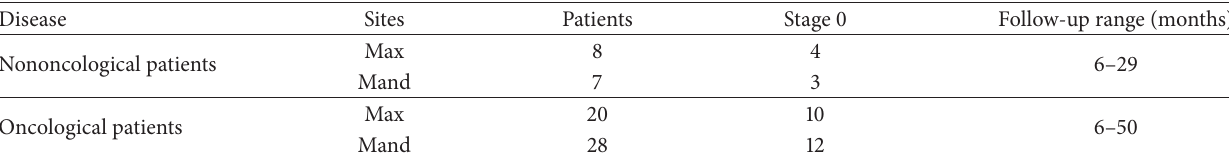
Table 5: Sites of occurrence of BRONJ.